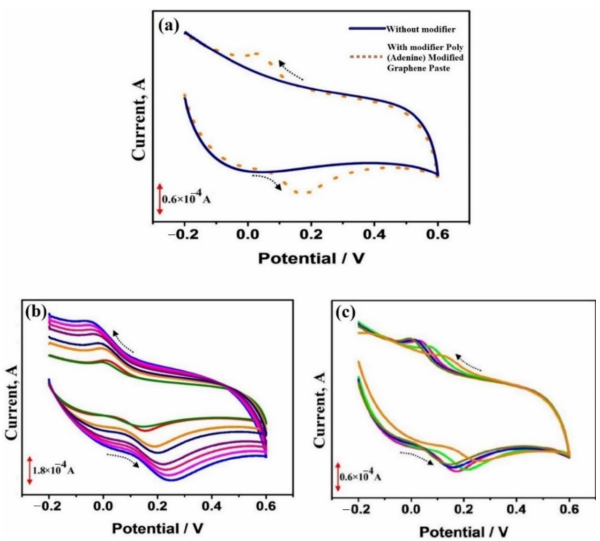
Figure 5. CV curve of catechol using a fabricated electrode at ( a ) 0.1 M PBS (pH 7) at the scan rate of 0.1 V/s. ( b ) Different scan rates from 0.1 to 0.3 V/s. ( c ) Different pH (6.5–8.0) with the sweep rate of 100 mV/s. Reprinted (adapted) with permission from Ref. [62]. Copyright 2020, Bentham